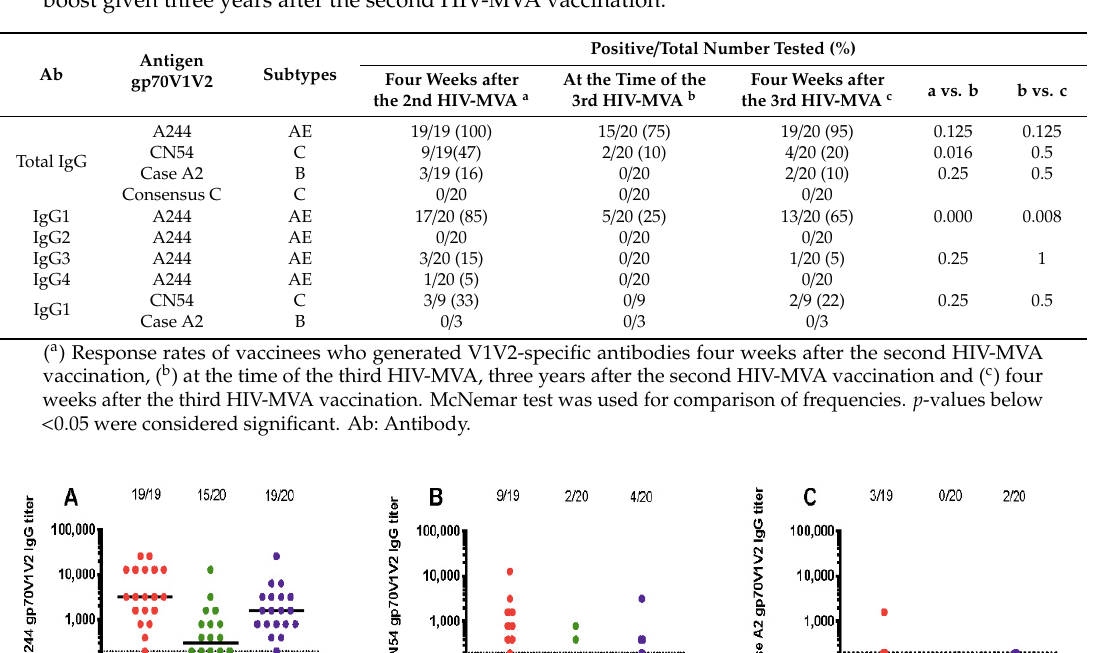
Table 2. Frequency of V1V2 IgG antibodies and IgG subtypes in 20 recipients of a late third HIV-MVA boost given three years after the second HIV-MVA vaccination.